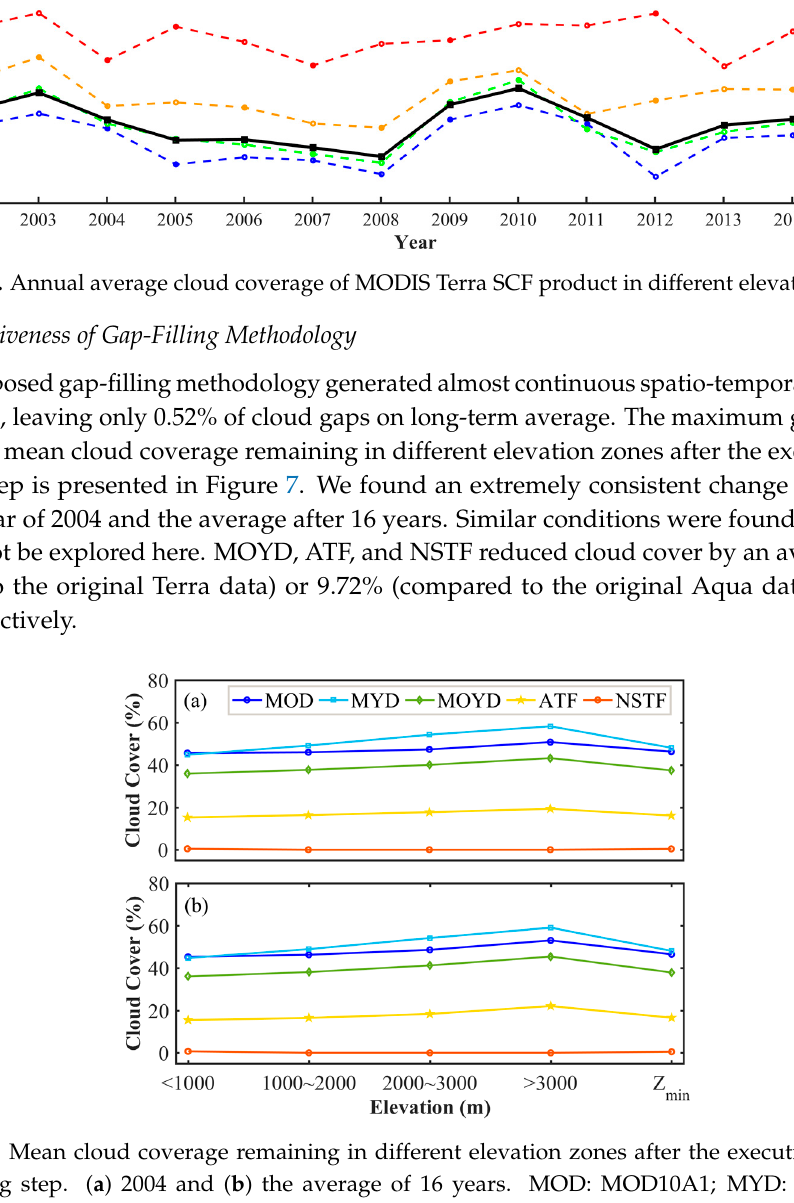
12 of 26 Figure 5. Cloud cover duration maps of the standard ( a ) MOD: MOD10A1 and ( b ) MYD: MYD10A1. We took MODIS Terra SCF products as an example (though there were similar patterns for MODIS Aqua). The calculated annual cloud coverage in different elevation zones are shown in Figure 6. From Figure 6, the annual average cloud coverage for each elevation zone demonstrates that the cloud obstruction probability increases with elevation. The annual average cloud percentages are 42– 48.94, 43.05–49.32, 45.07–52.12, 50.26–57.31, and 43.53–49.91 for elevations of <1000, 1000–2000, 2000– 3000, >3000 m, and the entire study area, with average values of 45.31, 46.30, 48.61, 53.09, and 46.52%, respectively. The systematic trends of cloud obstruction for the entire study area are the most